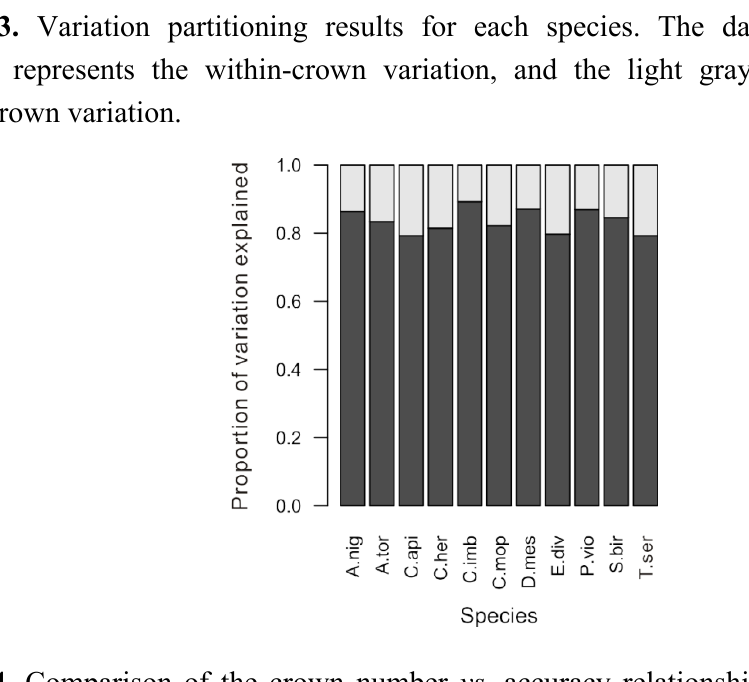
Figure 4. Comparison of the crown number vs. accuracy relationship for three ways of assigning training and test data: (i) assigning a specific number of crowns of each species to the training dataset and test dataset (black line; same as Figure 1b); (ii) training data made from an equal number of pixels randomly drawn from a set of training crowns but evaluating the accuracy with an independent set of crowns (gray line); and (iii) randomly assigning pixels to the training and test datasets such that the number of pixels assigned to each is equal to the amounts used in methods i and ii (dashed black